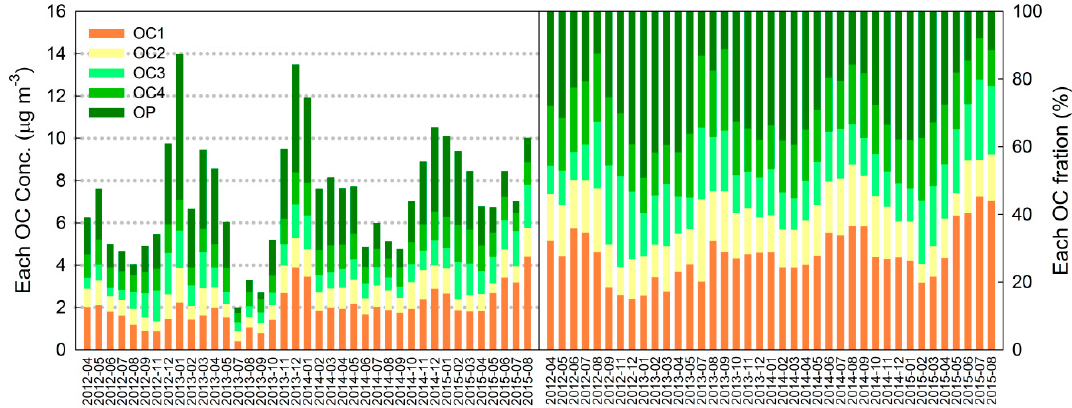
Figure 3. Monthly averaged concentrations (left) and fractions (right) of each of the OC fragments analyzed by the NIOSH method 5040.